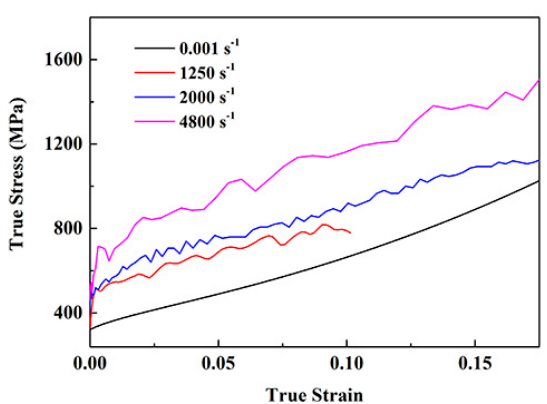
Figure 2. Compressive true stress vs. true strain curves of the deformed NiCrFeCoMn HEA at different strain rates.